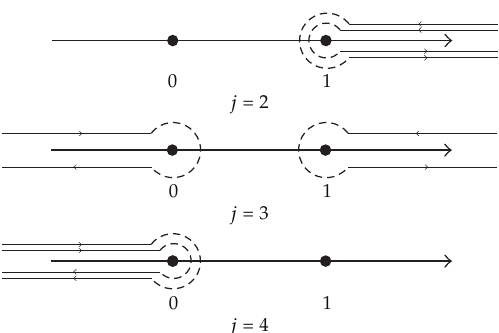
Figure 2: The three di ff erent ways of flipping contours in the five-point